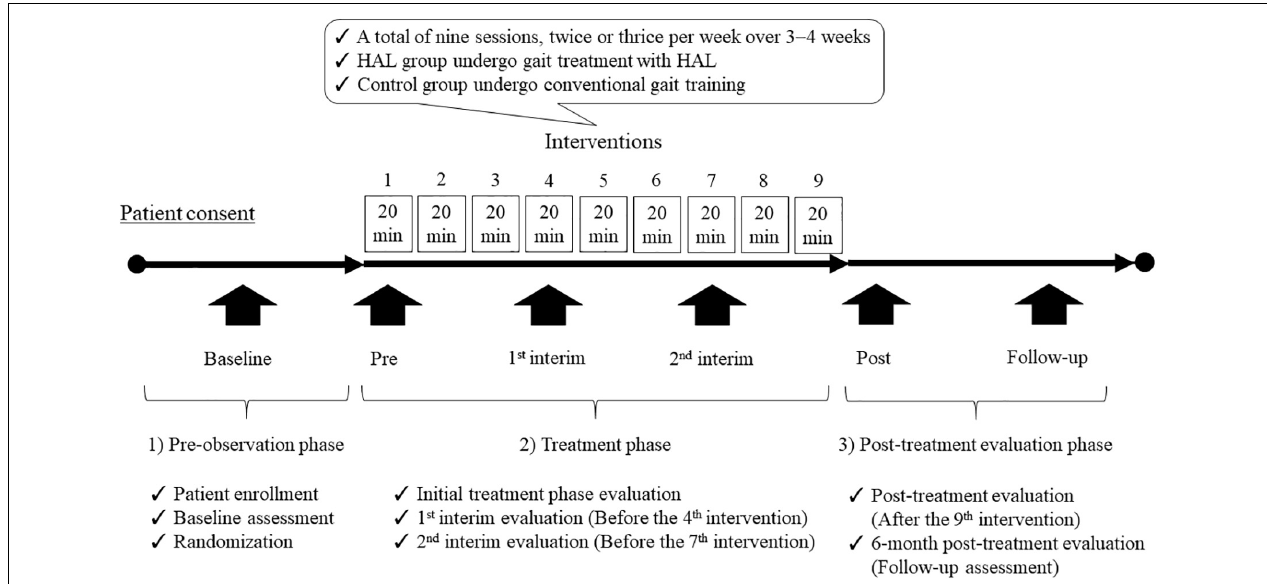
FIGURE 3 | Participant timeline of the study. This single-center, randomized, parallel-group, controlled trial will include three phases: (1) pre-observation phase (patient enrollment, baseline assessment, and randomization); (2) treatment phase [patients will undergo a total of nine sessions, twice or thrice per week over 3–4 weeks; the HAL and control groups will undergo gait treatment with HAL and CGT, i.e., walking aids and gait orthoses, respectively, as follows: initial treatment phase evaluation, 1st interim evaluation (before the 4th intervention), and 2nd interim evaluation (before the 7th intervention)]; and, finally (3) post-treatment evaluation phase (after the 9th intervention). Subsequently, a 6-month post-treatment evaluation (follow-up assessment) will be conducted to evaluate body functions, walking ability, ADL, and QOL in the post-observation phase. HAL, Hybrid Assistive Limb; CGT, conventional gait training; ADL, activities of daily living; QOL, quality of